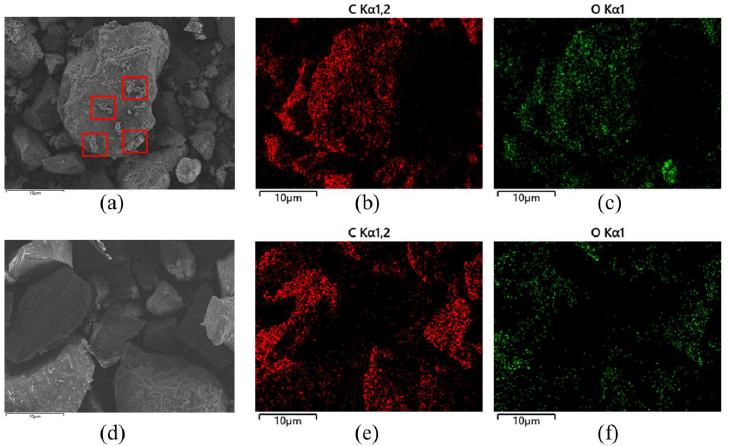
Figure 5. ( a ) SEM images of coal samples after treatment with OA:DD = 1:3 compound collector, as well as their ( b ) C and ( c ) O EDS images (red boxes represent the agglomeration process between particles). ( d ) SEM images of the raw coal, as well as their ( e ) C and ( f ) O EDS images.